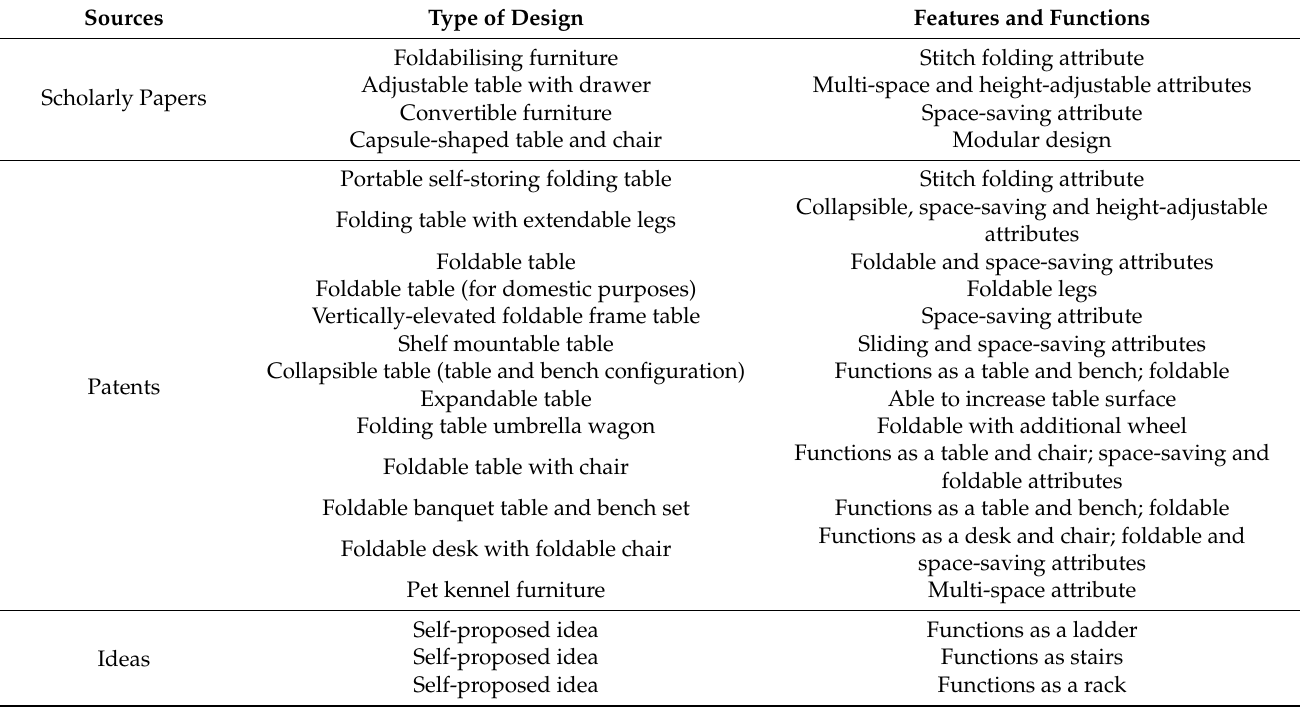
Table 2. List of features and functions from different sources.